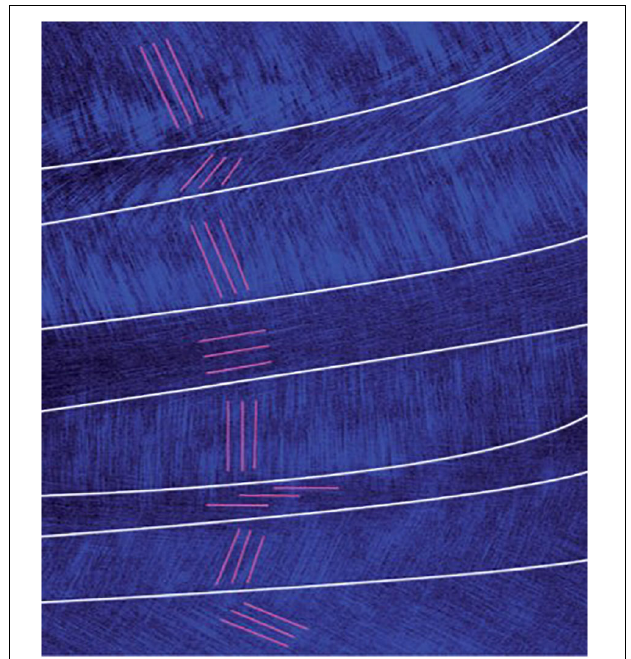
FIGURE 4 | Orientation of collagen fibers (in red) in eight-layered lamellae of grass carp under SEM (Feng et al., 2020).